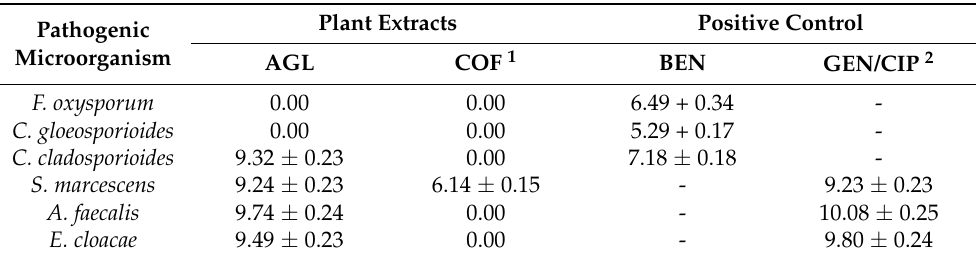
Table 1. Inhibition halos (mm) generated by the antimicrobial effect of A. glaucum leaf (AGL) and C. officinalis flower (COF) extracts.